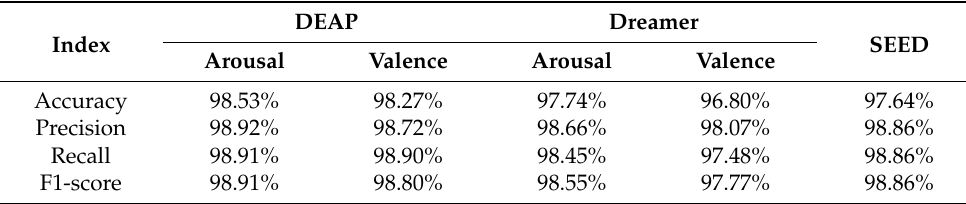
Table 7. The results of cross-dataset experiments.